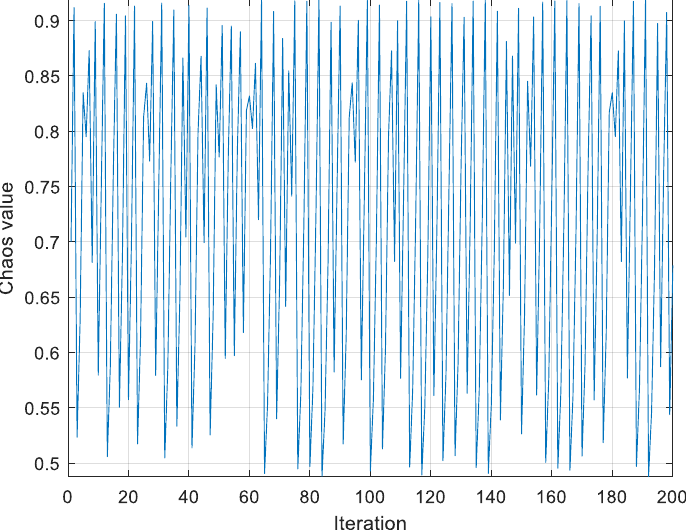
Figure 2. Sinusoidal chaotic sequence distribution.